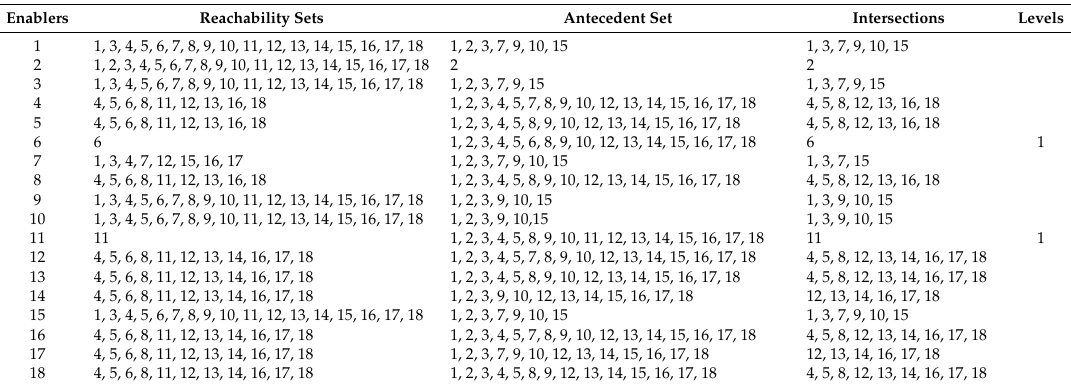
Table 6. Level partition for enablers—Iteration 1.